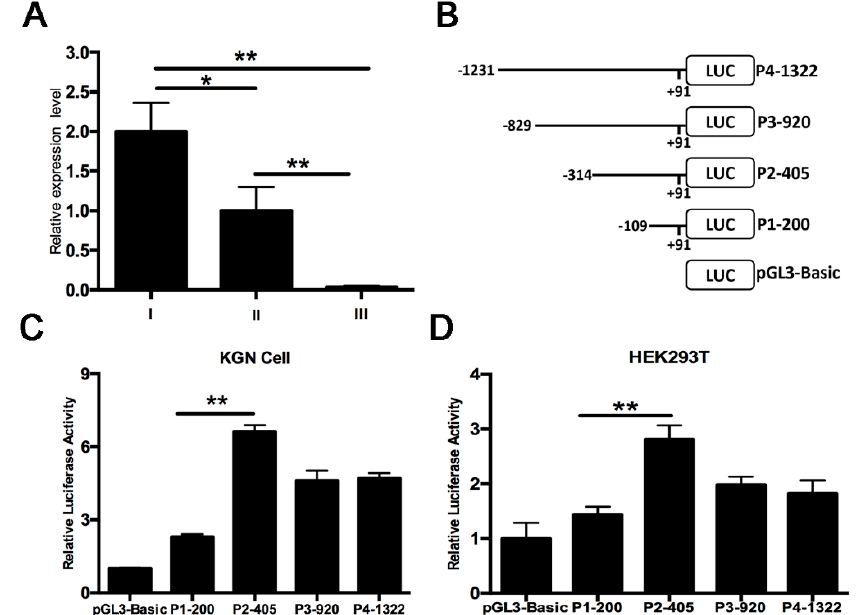
Figure 2. Identification of PII core promoter region of the ovine BMPR1B gene. ( A ) mRNA levels of the transcript variants of the ovine BMPR1B 5 (cid:48) -UTR in follicles of sheep ovary. ( B ) The schematic diagram of the deletion constructs. The 5 (cid:48) -end of transcript variant II was defined as + 1. ( C , D ) Luciferase assay. The deletion constructs were transfected into KGN cells ( C ) and HEK293T cells ( D ), and luciferase activity was measured using a Dual-Luciferase Reporter Assay System. Bars represent the mean ± SEM of at least three repeats. * p < 0.05, ** p < 0.01.